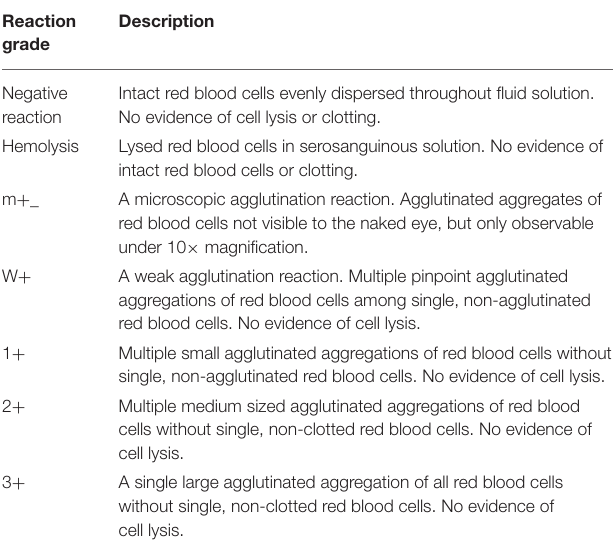
TABLE 2 | Summary of hematological parameters evaluated in 21 juvenile Galapagos sea lions ( Zalophus wollebaeki